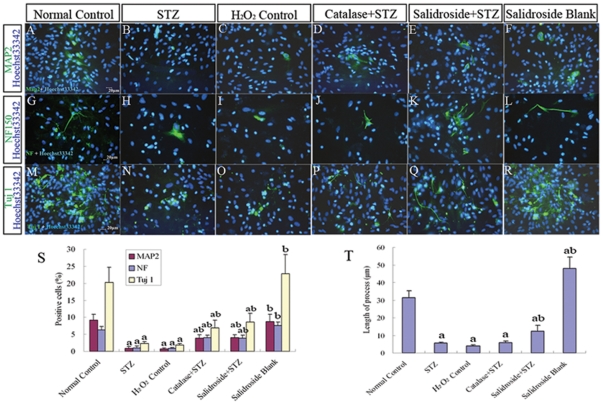
Immunofluorescence staining for MAP2, NF150 and Tuj1 in NSCs.(A–R) Representative photomicrographs of immunoreactive cells (green, nuclei counterstained with blue fluorescent stain Hoechst33342) for MAP2 (A–F), NF150 (G–L) and Tuj1 (M–R) in six experimental groups: Normal control group (A, G, M), STZ group (B, H, N), H2O2 control group (C, I, O), Catalase+STZ group (D, J, P), Salidroside+STZ group (E, K, Q) and Salidroside blank group (F, L, R). (S) Bar chart showing the percentages of immunoreactive cells for MAP2, NF150 and Tuj1. (T) Bar chart showing the average length of cellular processes from NF150 immunoreactive cells. Values are expressed as mean±SD. a
p<0.05 compared with the normal control group; b
p<0.05 compared with the STZ group.